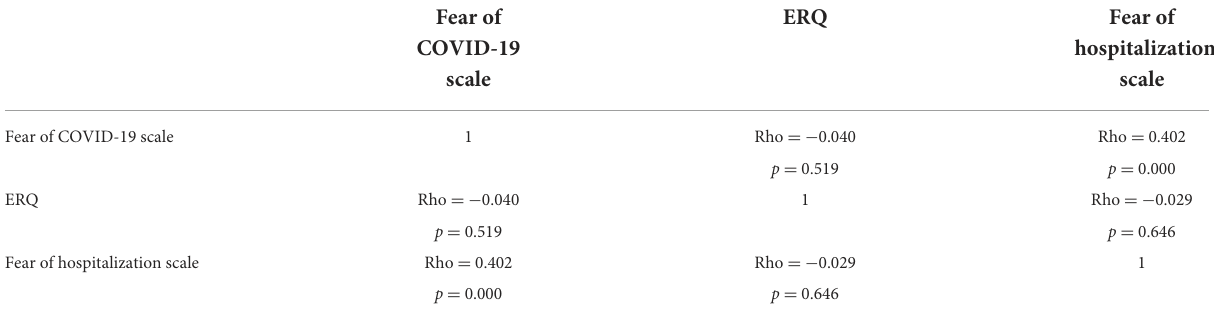
TABLE 5 Non-parametric Spearman’s